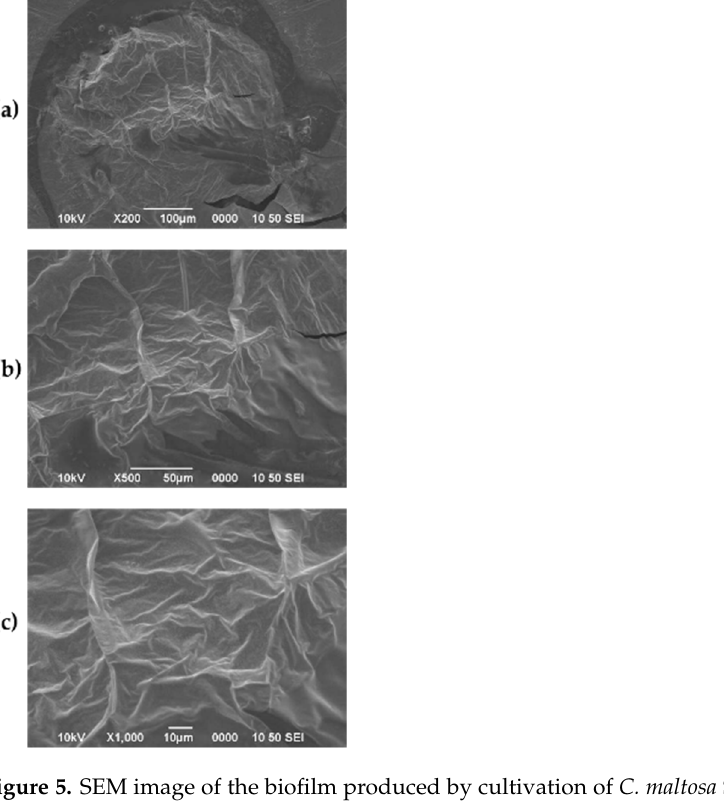
8 of 15 Figure 4. Pareto charts of standardized effects for biofilm production ( a ) and growth rate ( b ); A is agitation and B is aeration. The yeast growth rate increased with the increase in the aeration, especially when the cultivation was performed under a low agitation speed (Figure 3b). At the same time, the agitation speed resulted in directly proportional influence on the growth rate only under low air inflow. The highest biomass production was achieved under an aeration of 3 L min − 1 and an agitation of 100 rpm. The air inflow was the variable exerting the strongest effect (Figure 4b). 3.3. Characterization of the Biofilm 3.3.1. SEM SEM was used as a tool for characterization of the produced biofilms. SMS imaging of the purified biofilm resulting from the cultivation at 200 rpm and 1 L min − 1 reveals a